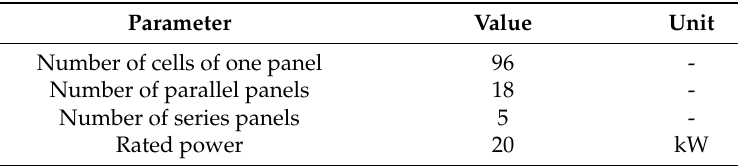
Table 2. Parameters of PV panels.